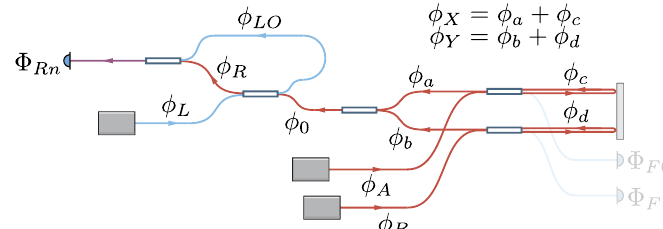
Figure 3. Return path phase contributions from each unique length of fiber in the optical system. For clarity, only two fibers are